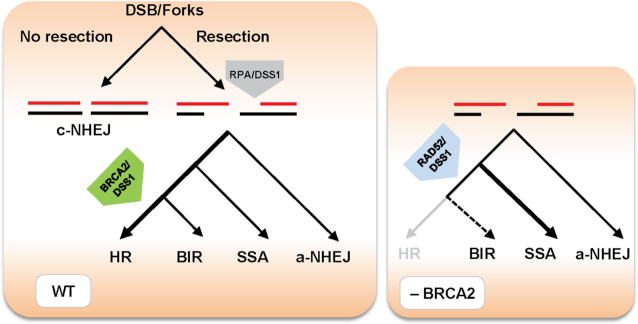
Model describing possible mechanism of RAD52-DSS1 activity in the DSB repair. DSBs or stalled replication forks are resected to produce ssDNA required for homology-directed repairs, alternatively blocked resection allows repair by c-NHEJ. While initial small resection makes DNA ends available for a-NHEJ, extensive resection generates long ssDNA stretches occupied by RPA. BRCA2 in the complex with DSS1 helps to alleviate RPA inhibitory effect and load RAD51 presynaptic filament to promote HR. RAD52-mediated SSA/BIR represents an alternative repair pathway, where DSS1 may facilitate this process via stimulation of RAD52 binding and strand invasion activities. Therefore, in the absence of BRCA2, RAD52/DSS1 becomes essential to process breaks/forks via SSA/BIR pathways.